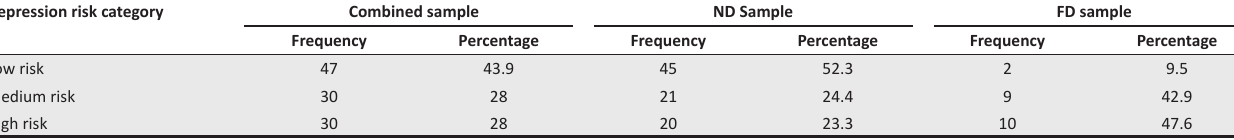
TABLE 5: Depression symptom risk category for the combined, No diagnosis and FD samples. Depression risk category